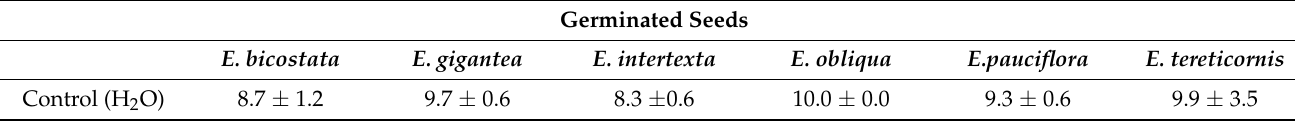
Table 2. Phytotoxic activity of the EOs on R. sativus . Germinated